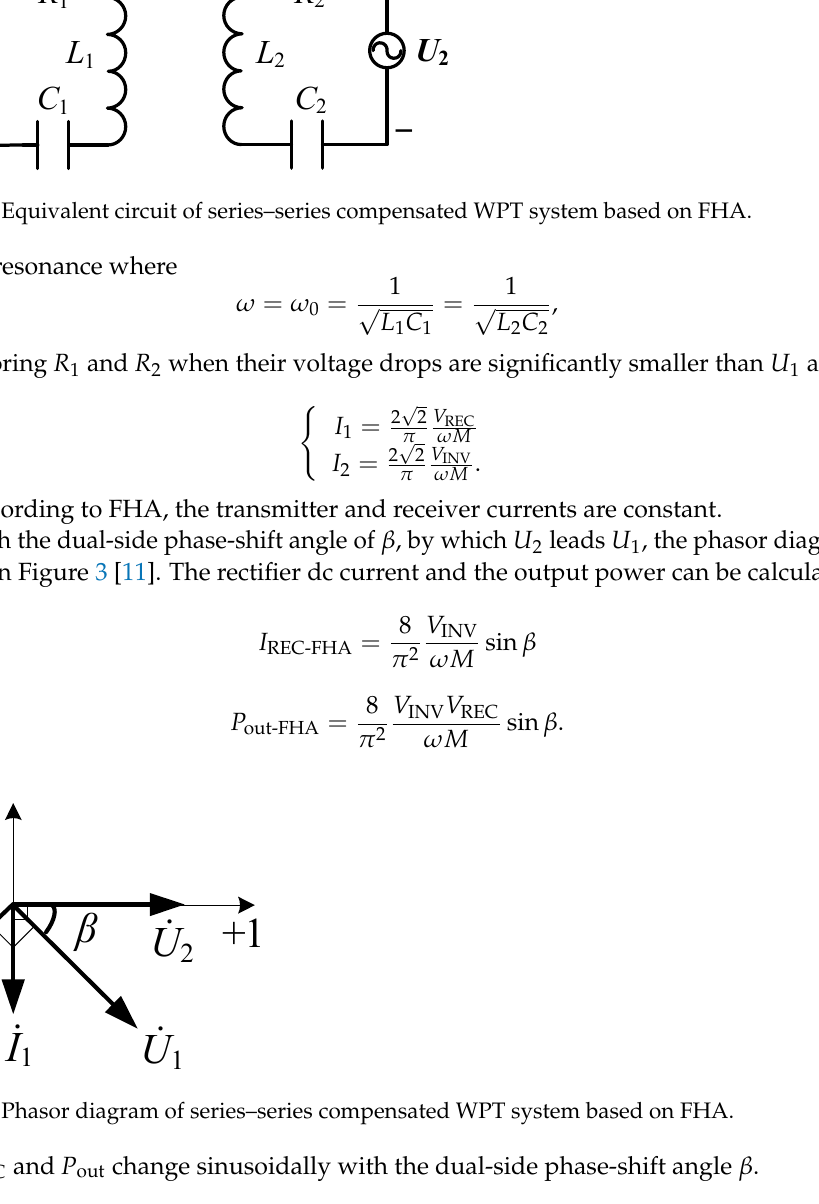
Figure 3. Phasor diagram of series–series compensated WPT system based on FHA. I REC and P out change sinusoidally with the dual-side phase-shift angle β